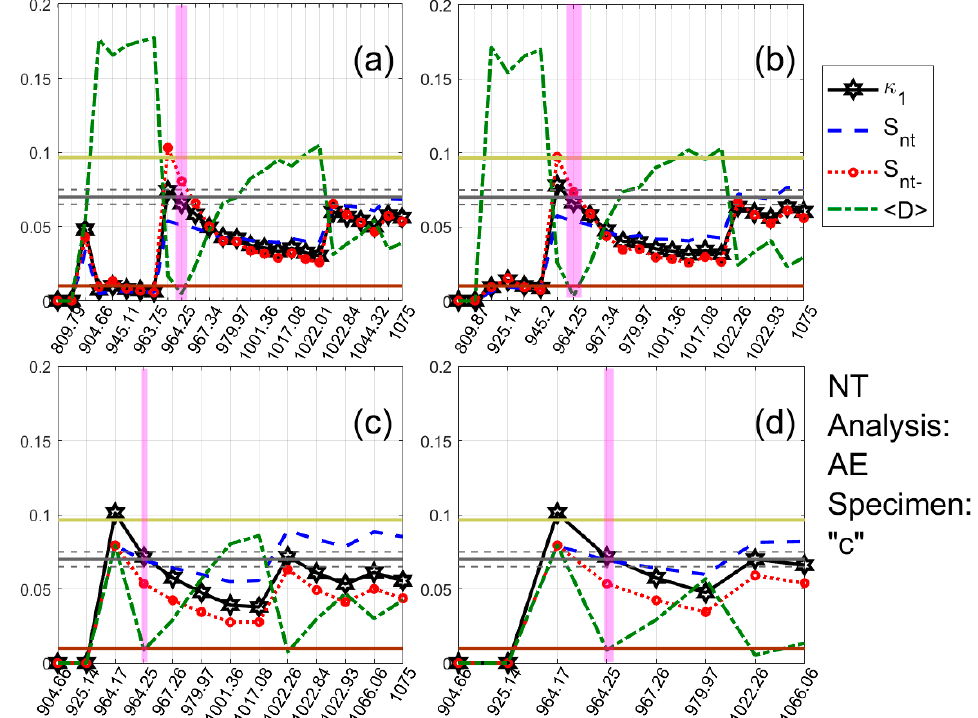
Figure 5. NT analysis of the AE time series acquired during the experiment involving specimen ( c ) of Figure 3. The di ff erent panels correspond to di ff erent threshold values : ( a ) 0.1, ( b ) 0.2, ( c ) 0.7 and ( d ) 2. Each panel shows, on a common vertical axis, the variation of the values of all parameters of the applied NT analysis vs. time in seconds (0 s corresponds to the initiation of the experiment). The vertical magenta patches highlight the time when criticality is approached for each threshold, i.e., when criticality conditions (cf. Section 4) are satisfied. For the ease of interpreting the results, the κ 1 = 0.070 value is shown as a solid grey horizontal line, while the following limit values have also been depicted by horizontal lines: (cid:104) D (cid:105) limit (10 − 2 ), solid brown line; entropy limit S u ( ≈ 0.0966 ) , solid light green. The horizontal grey dashed lines at 0.070 ± 0.005 define the limits of the zone within which a calculated κ 1 value is considered to be ≈ 0.070. Note that the employed events are presented equispaced in the horizontal axis following the NT representation, but the time values presented are conventional time values for easier identification of the conventional time of approach to criticality; therefore, the horizontal axis is not linear in terms of the conventional